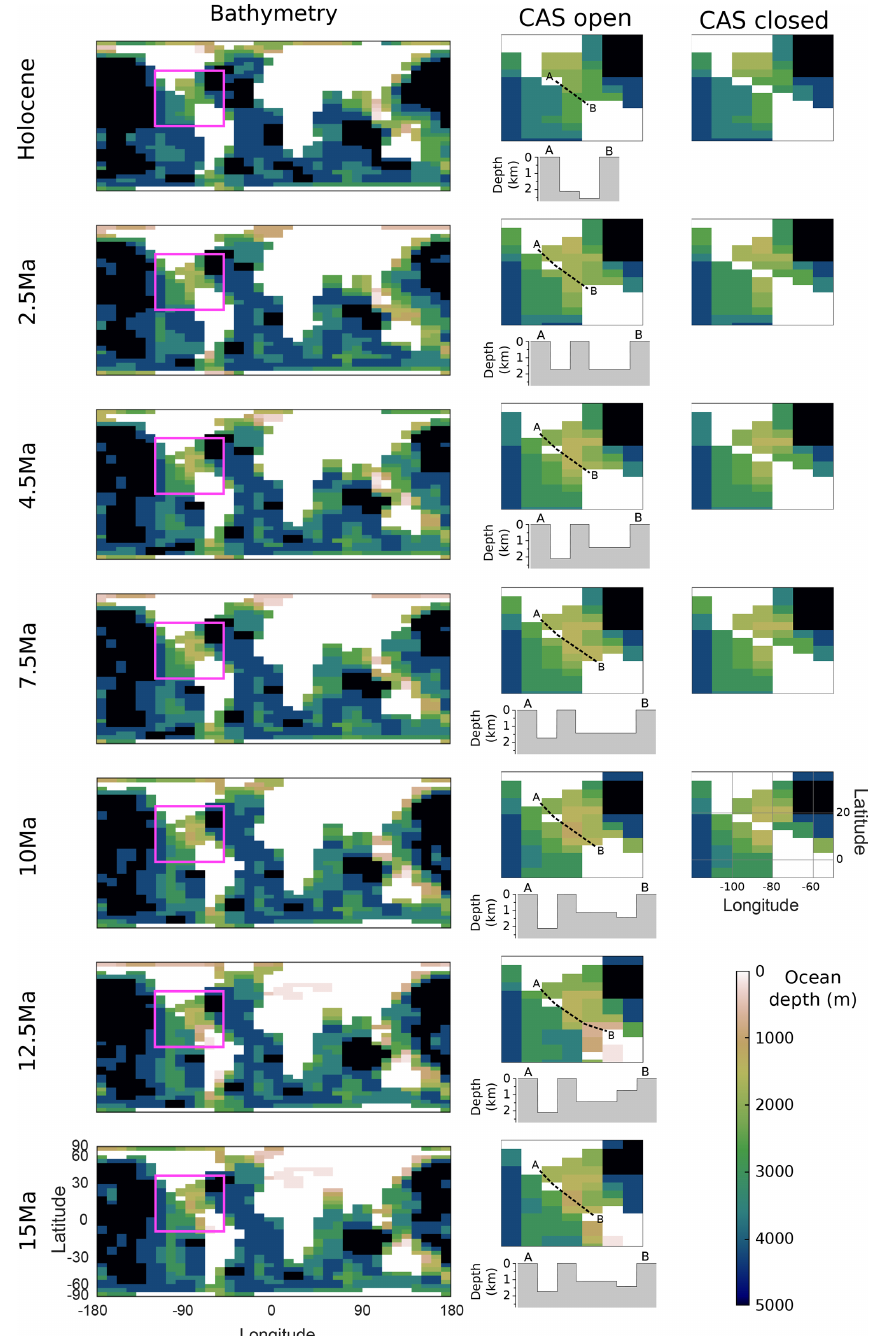
Figure 3. Model bathymetry and coastlines for each time slice, and a close-up of the region covering the Central American Seaway (CAS), including a transect showing the most depth-restricted pathway for the open-CAS configurations and the ocean depths for both open- and closed-CAS